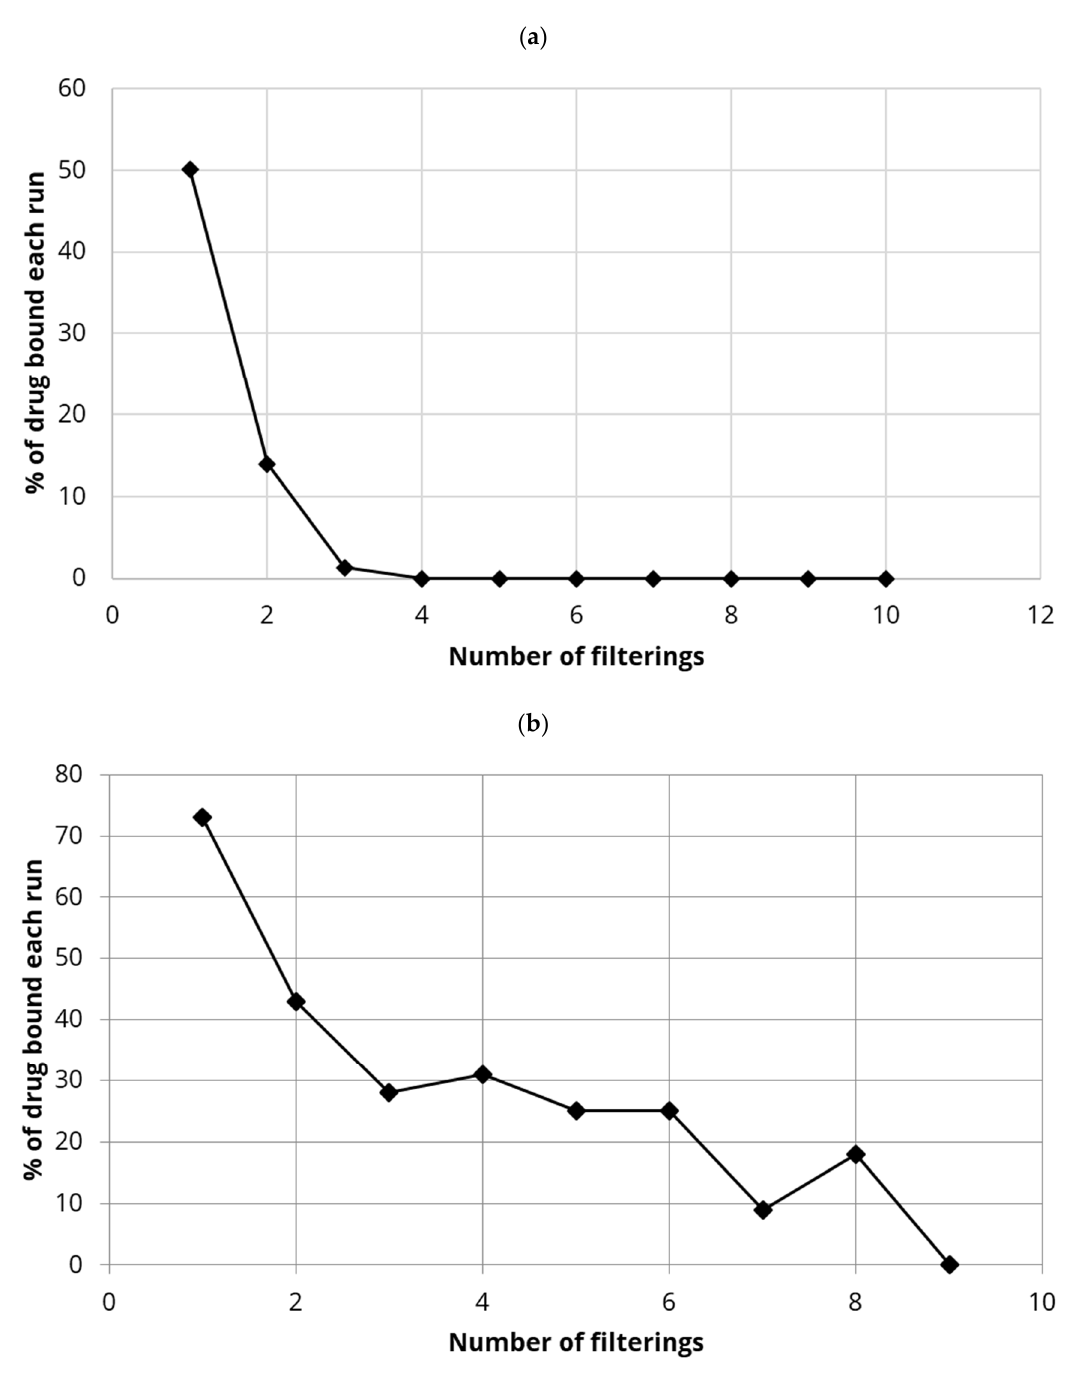
Figure 6. ( a ). Binding percentage of estradiol (repeated volumes of 5 mL of 2 µg/mL) for DDSA-CNC (5 mg integrated into the small-scale filter). ( b ). Binding percentage of estradiol (repeated volumes of 5 mL of 2 µg/mL) for DDSA-CNC (10 mg integrated into the small-scale filter.